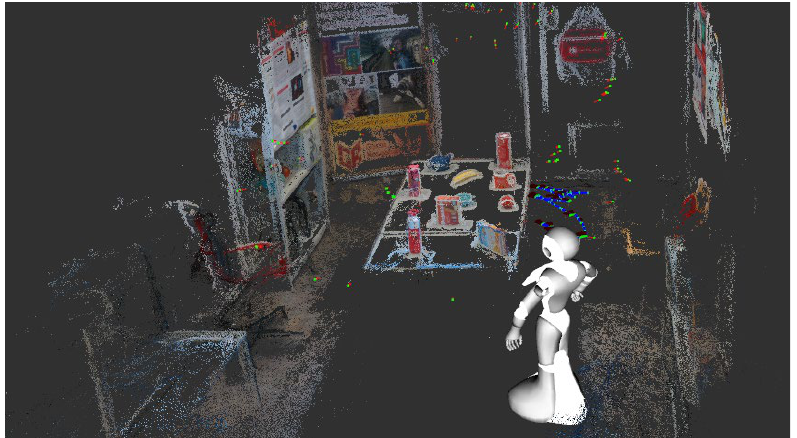
Figure 8. Snapshots from our simulator showing a robot synthesizing data. Green points and red lines are positions and view directions of input cameras, black lines are the view directions of the virtual camera, and the long line is the whole trajectory of the virtual